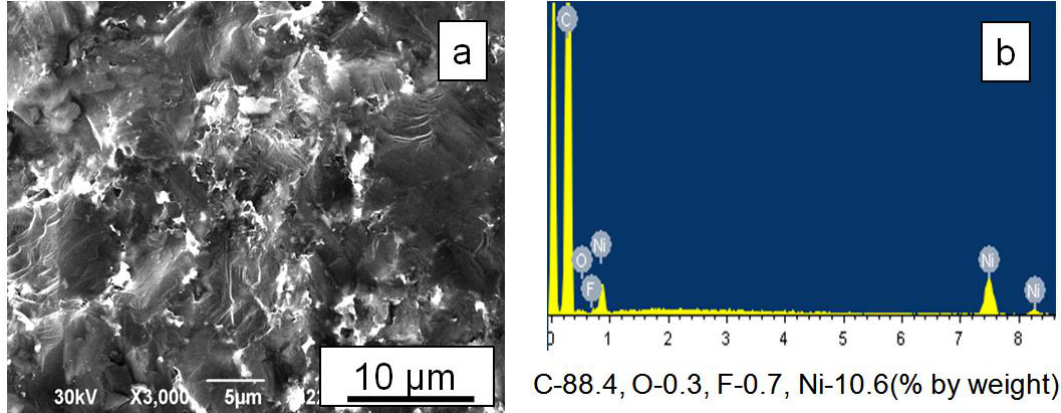
Figure 3. ( a ) SEM image and ( b ) elemental analysis of the fracture surface of the FDM sample infiltrated with nickel at 7 GPa and 1600 °C.